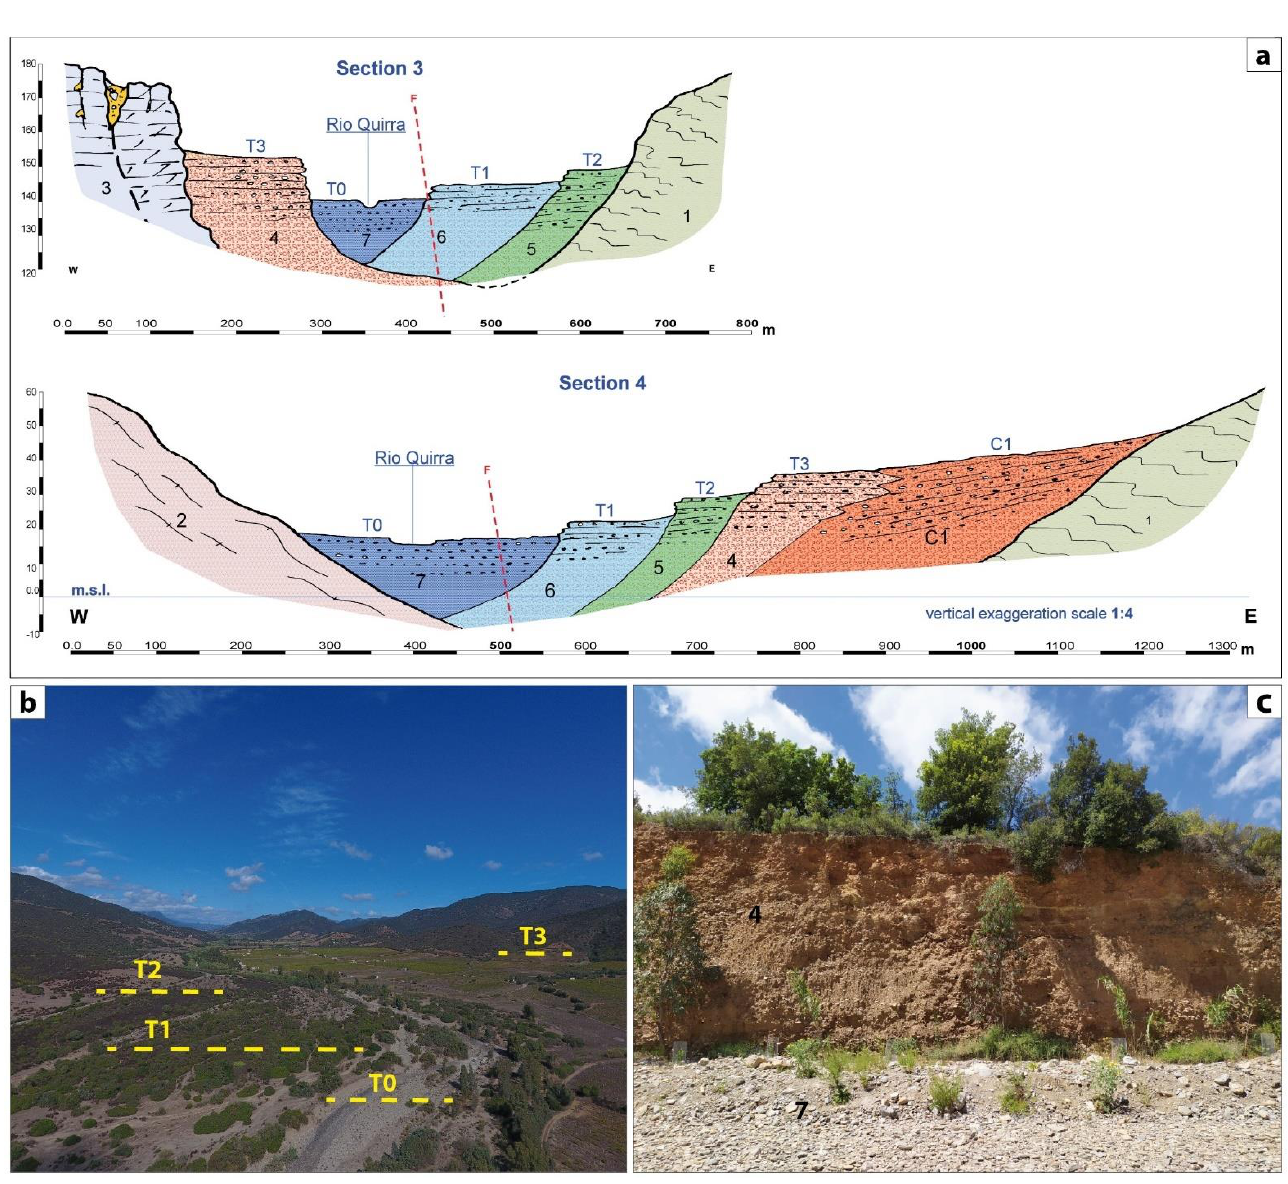
Figure 11. ( a ) Morphostratigraphic profiles of the Quirra River. ( b ) UAV photo in the river alluvial plain. ( c ) Outcrop of Terrace T3. Lithological legend: (1) Filladi Grigie del Gennargentu Formation; (2) Monte Santa Vittoria Formation; (3) paleo-DGSD; (C1) paleo-conoid; (4) T3; (5) T2; (6) T1; (7) T0.